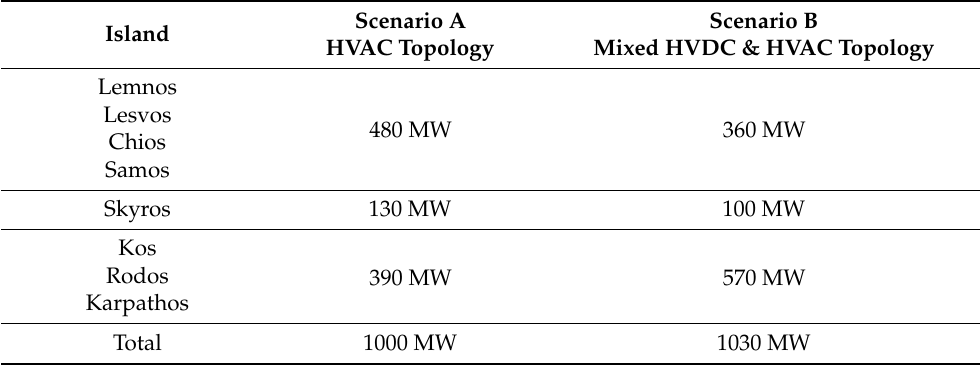
Table 2. New RES development capacity per island cluster after